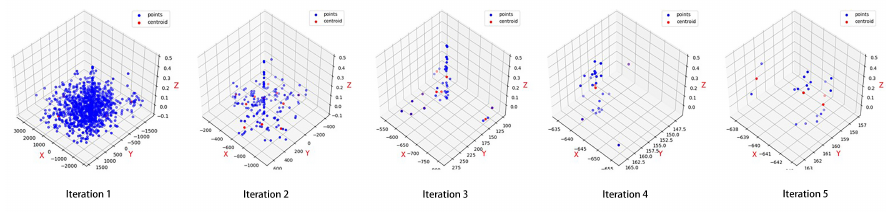
Figure 5. Scattered point distribution during iteration. The blue dots represent all the data in the iteration; the red dots represent the centroids of the clusters. As the number of iterations increases, the number of putative matches decreases, the input point set approaches the inlier set, and the number of clusters divided by each cluster is also decreased